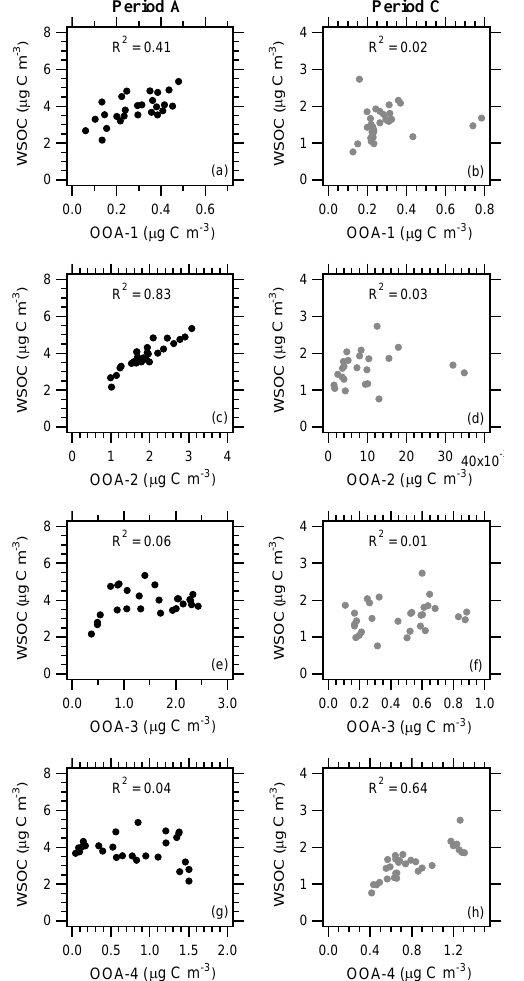
Figure 10. Correlation of hourly averaged WSOC vs. AMS ME-2 factors OOA-1 for (a) Period A and (b) Period C, OOA-2 for (c) Pe- riod A and (d) Period C, OOA-3 for (e) Period A and (f) Period C, and OOA-4 for (g) Period A and (h) Period C at SPC. All plots are for during the times of RH increasing.